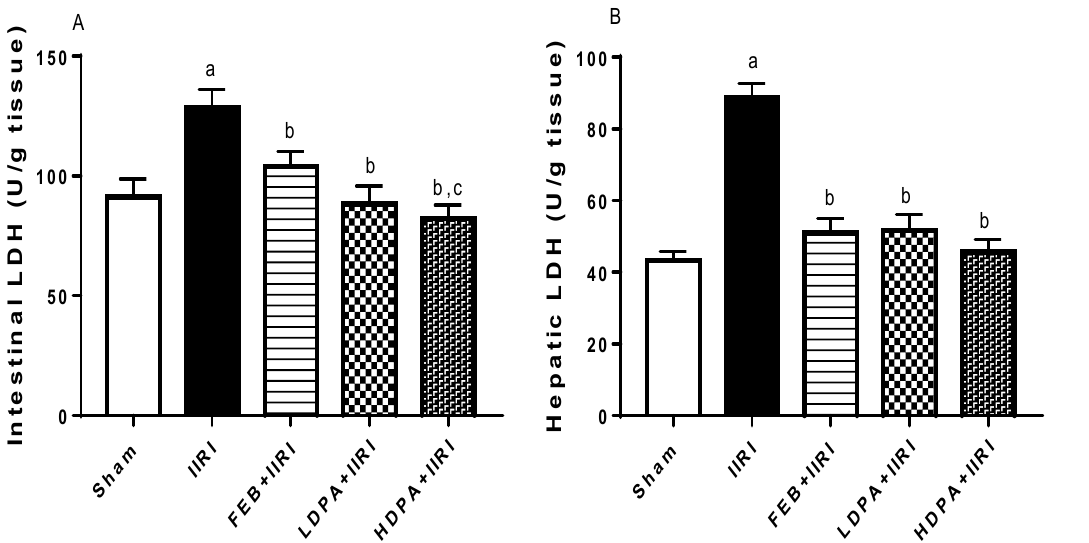
Figure 3. Effect of intestinal ischemia/reperfusion (I/R) and methanolic Phyllanthus amarus leaf extract on intestinal and hepatic lactate dehydrogenase (LDH) activities. FEB, LDPA, and HDPA significantly reduced IIRI-induced rise in intestinal LDH ( A ) and hepatic LDH ( B ). IIRI: intestinal ischemia/reperfusion injury, FEB: febuxostat, LDPA: low-dose Phyllanthus amarus , HDPA: high-dose Phyllanthus amarus , a p < 0.05 versus sham, b p < 0.05 versus IIRI, c p < 0.05 versus FEB + IIRI. Values represent the mean for ten replicates ± the standard deviation.